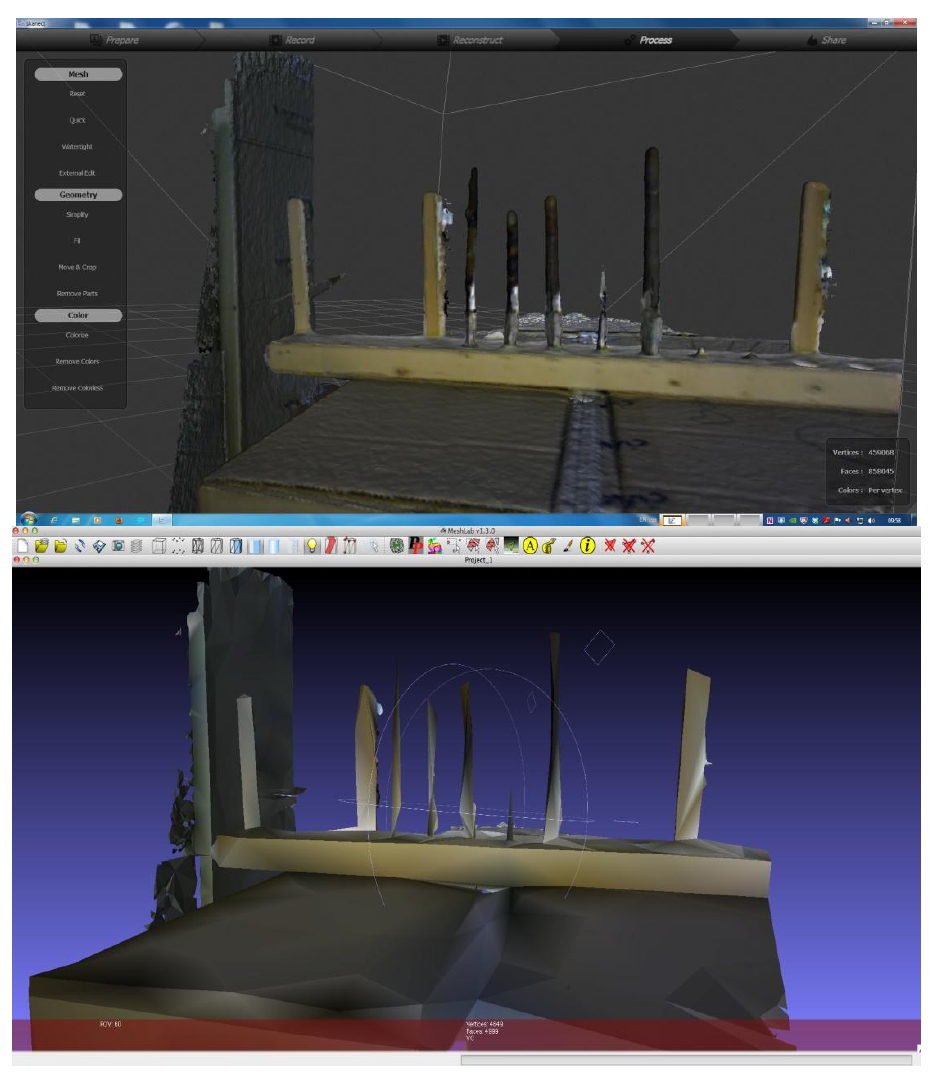
Figure 6. Example of 3D scanning of woody branches using Skanect and an Asus Xtion. Top: original high-resolution mesh of woody branches scanned from ~60 cm using Skanect. Bottom: a low-resolution mesh export is the only option available until a license is